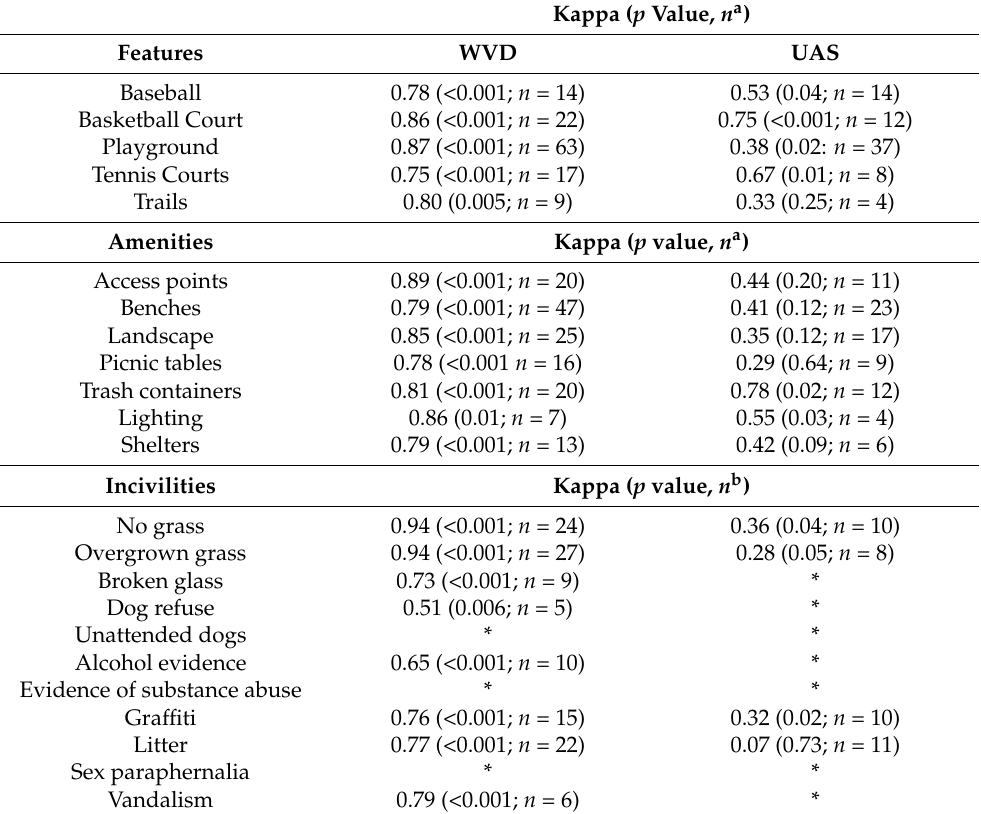
Table 1. Agreement between in-person and WVD and UAS PARAs on the quality of park features and amenities and the severity of